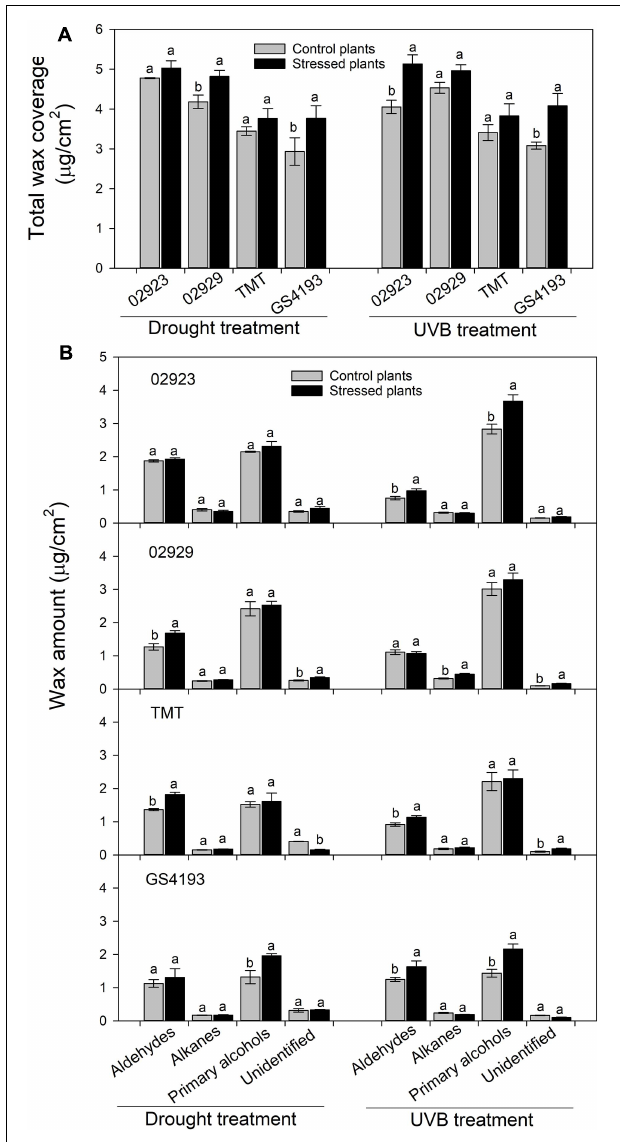
FIGURE 4 | The wax coverage (A) and relative abundance of wax compositions (B) of Medicago ruthenica under enhanced UVB and drought treatments. Different lowercase letters above the data bar within each wax class represented significance at P < 0.05 according to Least Significant Difference